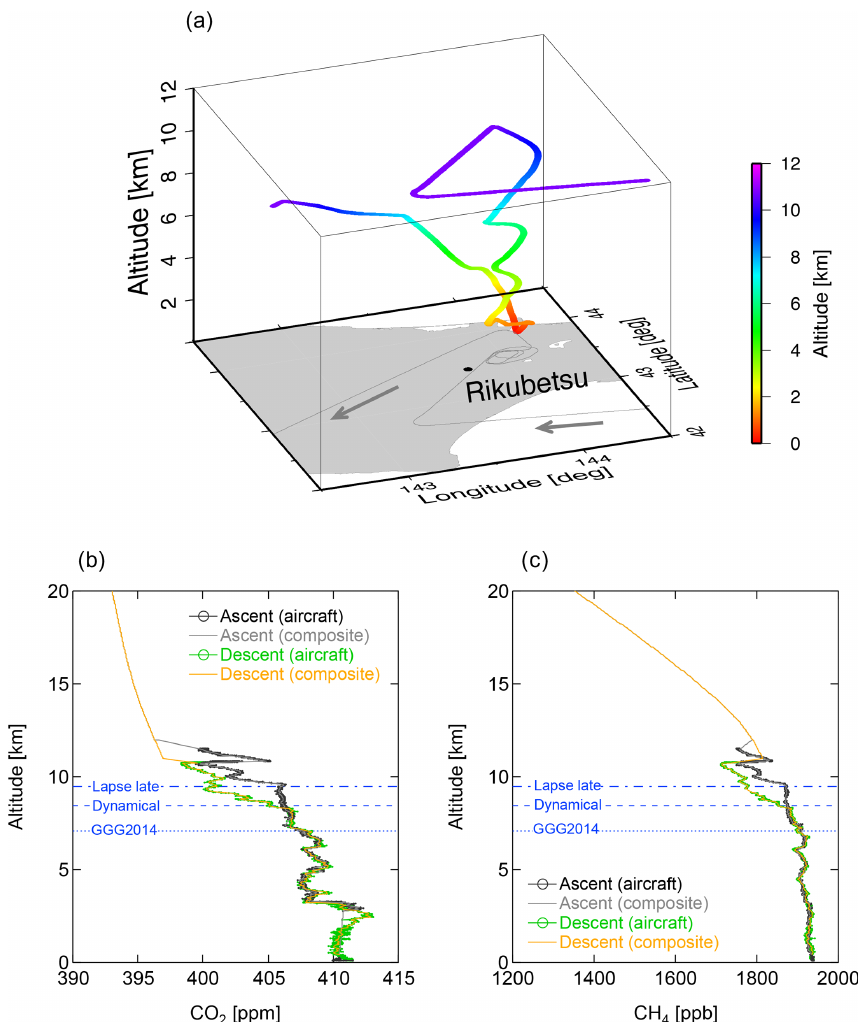
Figure 1. (a) Aircraft flight track over Hokkaido, Japan, on 27 April 2016 during the KORUS-AQ campaign. The arrows indicate the flight direction, and the thin solid line represents the flight track projected on the ground. (b, c) The descending (green) and ascending (black) CO 2 and CH 4 mole fraction profiles measured by airborne instruments. Also shown are the descending (yellow) and ascending (gray) composite profiles that are used for calculating the column-averaged dry-air mole fractions. The horizontal lines indicate the lapse rate tropopause and the dynamical tropopause over Rikubetsu at 03:00UTC and the GGG2014-derived tropopause over